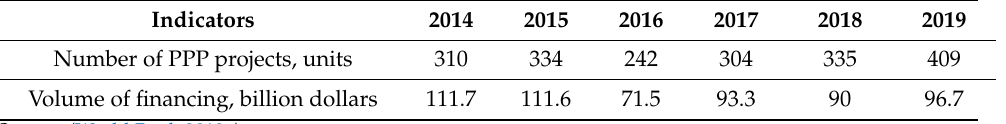
Table 1. Dynamics of changes in PPP projects funding by World Bank structures. Indicators 2014 2015 2016 2017 2018 2019 Number of PPP projects, units 310 334 242 304 335 409 Volume of financing, billion dollars 111.7 111.6 71.5 93.3 90